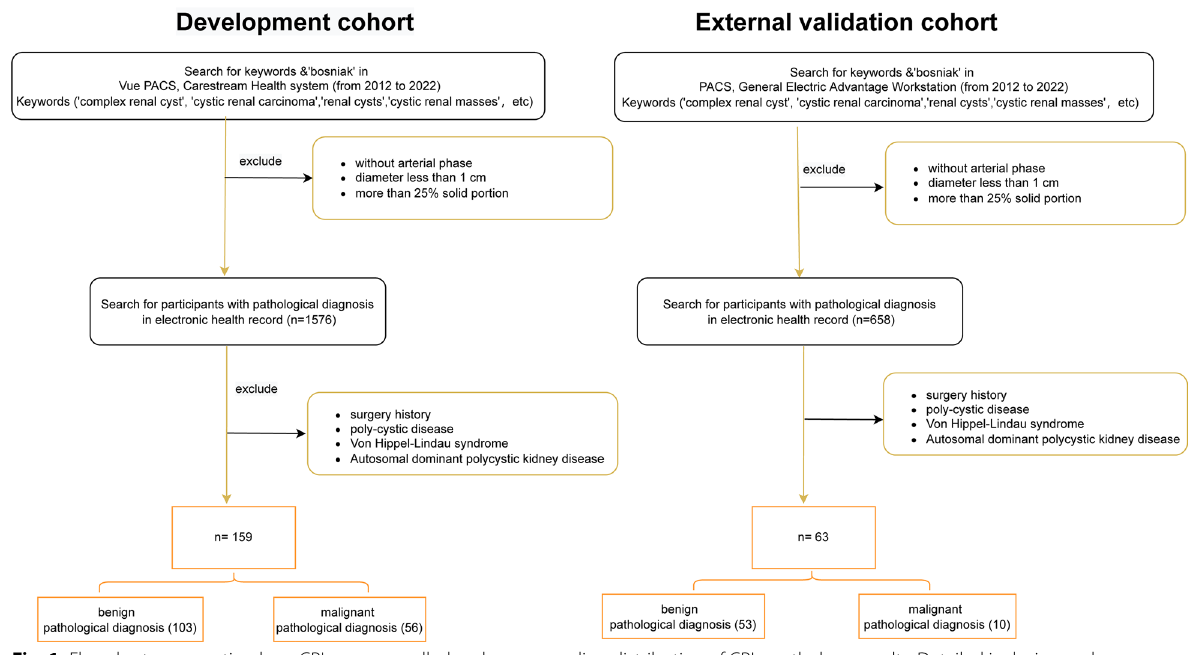
Fig. 1 Flowchart representing how CRLs were enrolled and corresponding distribution of CRLs pathology results. Detailed inclusion and exclusion criteria are displayed in the flowchart. CRLs were classified as benign or malignant CRLs based on pathological results. Following that, training cohort were adopted to build machine learning classifier and testing cohort were used to evaluate model performance compared